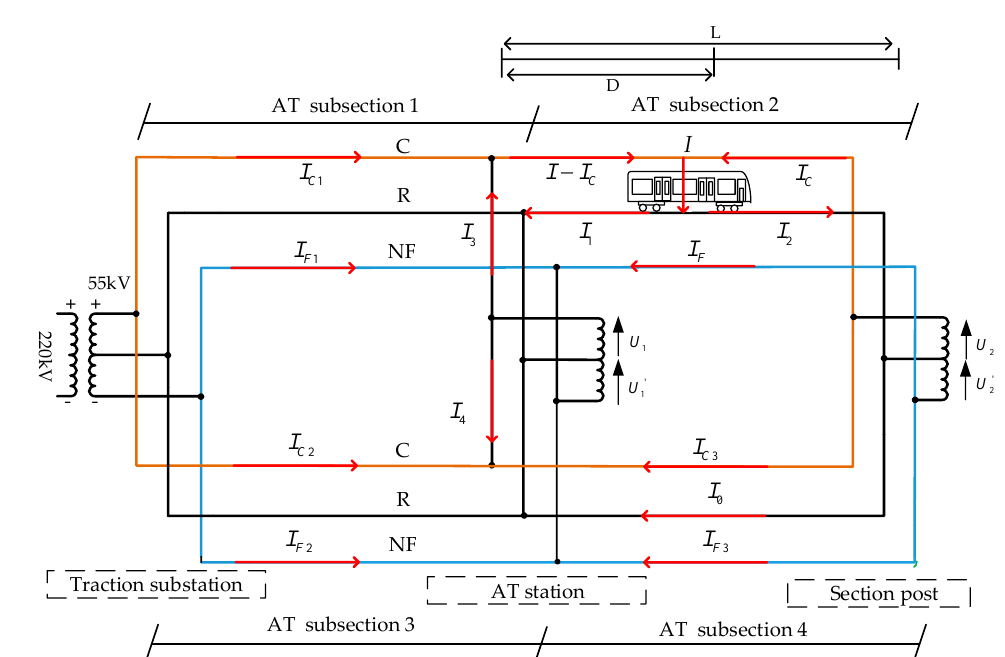
Figure 3. Current and voltage distribution of all parallel AT TPSS in case of an electric multiple units (EMU) running at the AT subsection 2.